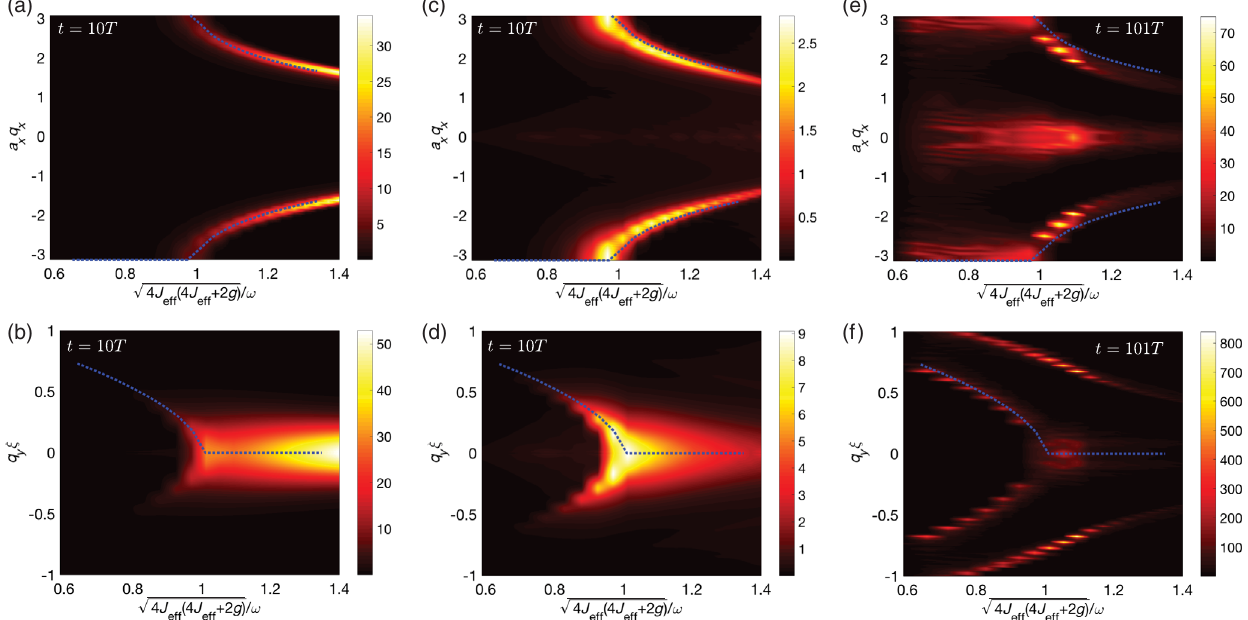
FIG. 19. Quasiparticle momentum distribution function n for the 2D band model from Sec. VI B (with a lattice along the x direction ffiffiffiffiffiffiffiffiffiffiffiffiffiffiffiffiffiffiffiffiffiffiffiffiffiffiffiffiffiffiffiffiffiffiffiffiffiffi p q 4 j J 4 j J 2 g Þ = ω and of q and a continuum along the y direction), as a function of the parameter (upper line) [resp. q ⊥ (lower x eff jð eff j þ line)], after integration over q ⊥ (resp. q ), and computed as follows: (left panels) after a time t ¼ 10 T using the linearized dynamics, x (middle panels) same time but using the WCCA, and (right panels) after a longer time t ¼ 101 T using the WCCA. The dotted blue line indicates our theoretical prediction for the most unstable mode (see Table II), which is verified in all regimes: For ffiffiffiffiffiffiffiffiffiffiffiffiffiffiffiffiffiffiffiffiffiffiffiffiffiffiffiffiffiffiffiffiffiffiffiffiffiffi p ffiffiffiffiffiffiffiffiffiffiffiffiffiffiffiffiffiffiffiffiffiffiffiffiffiffiffiffiffiffiffiffiffiffiffiffiffiffi p 4 j J 4 j J 2 g Þ 4 j J 4 j J 2 g Þ = ω > 1 , we find q mum ⊥ ¼ 0 and q mum < π , as predicted by Eq. (37); for = ω < 1 , we find x eff jð eff j þ eff jð eff j þ > 0 , as given by Eq. (35). Note that, in the latter regime, the peaks are only apparent after a long time (here 101 T , right panel) because of the small values of the corresponding instability rates; see also Fig. 18(a), where these peaks are made visible. As already observed in Fig. 16, both linearized and WCCA agree very well on the position of the peaks, although the WCCA predicts a broadening of the instability zone due to nonlinear couplings between the modes. Note that at longer times (right panel), higher-order parametric resonances are also visible. The apparent “ quantized ” character of the resonant peaks for t ¼ 101 T is a numerical artifact due ffiffiffiffiffiffiffiffiffiffiffiffiffiffiffiffiffiffiffiffiffiffiffiffiffiffiffiffiffiffiffiffiffiffiffiffiffiffi p 4 j J 4 j J 2 g Þ = ω used in the numerical to the discretization of the variable eff jð eff j þ